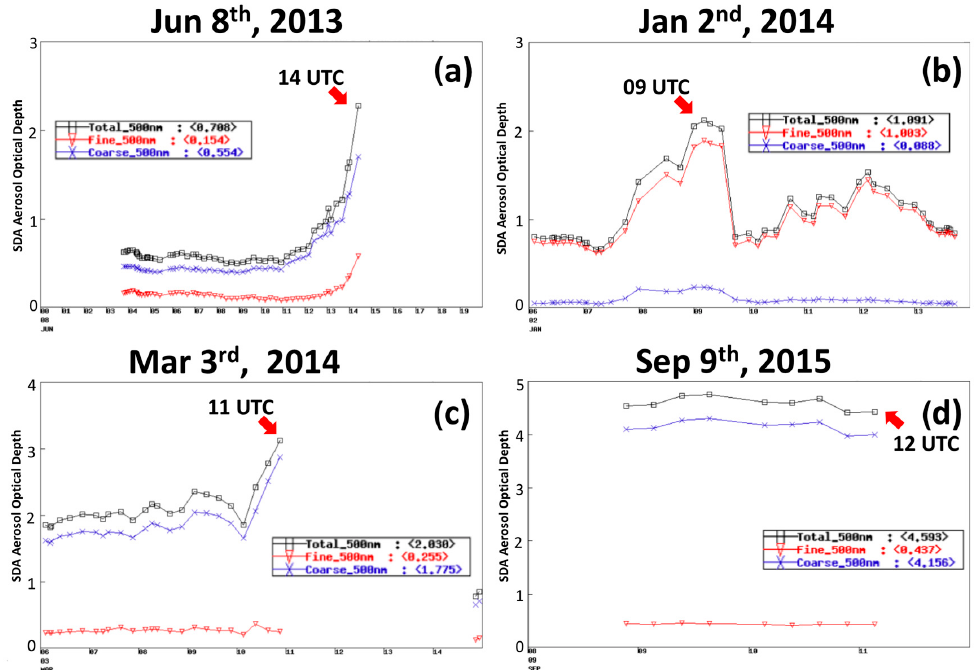
Figure 5. Time series of AERONET Daily 500-nm AOD spectral deconvolution algorithm (SDA) retrievals during ( a ) 8 June 2013, ( b ) 2 January 2014, ( c ) 3 March 2014, and ( d ) 9 September 2015, respectively. Black/blue/red lines represent total/coarse/find aerosols, respectively.